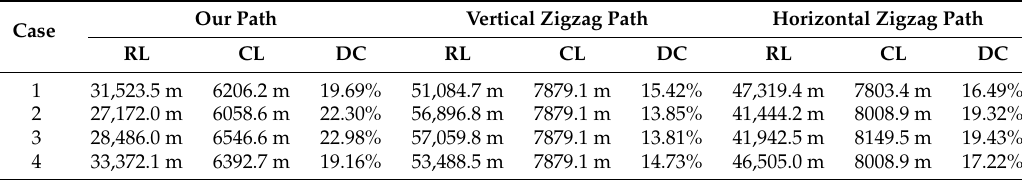
Table 5. Performance of the proposed and the zigzag path planners.